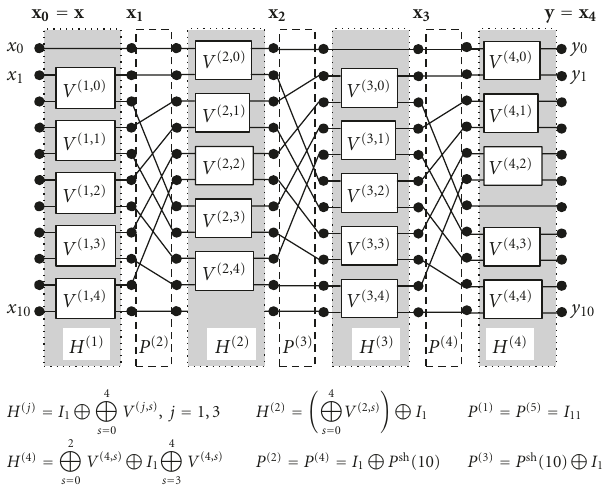
Haar transform is the classical representative of Ω . It is ob- N , k ≡ 0, P ( j ) , j = 1, ... , m , is the tained by taking m = log 1 2 perfect shu ffl e permutation matrix of order N j = (cid:4) N/ 2 j (cid:5) , √ and V ( j , s ) = (1 / 2)[ 1 1 ], j = 1, ... , m , s = 0, ... , N/ 2 j − 1 − 1